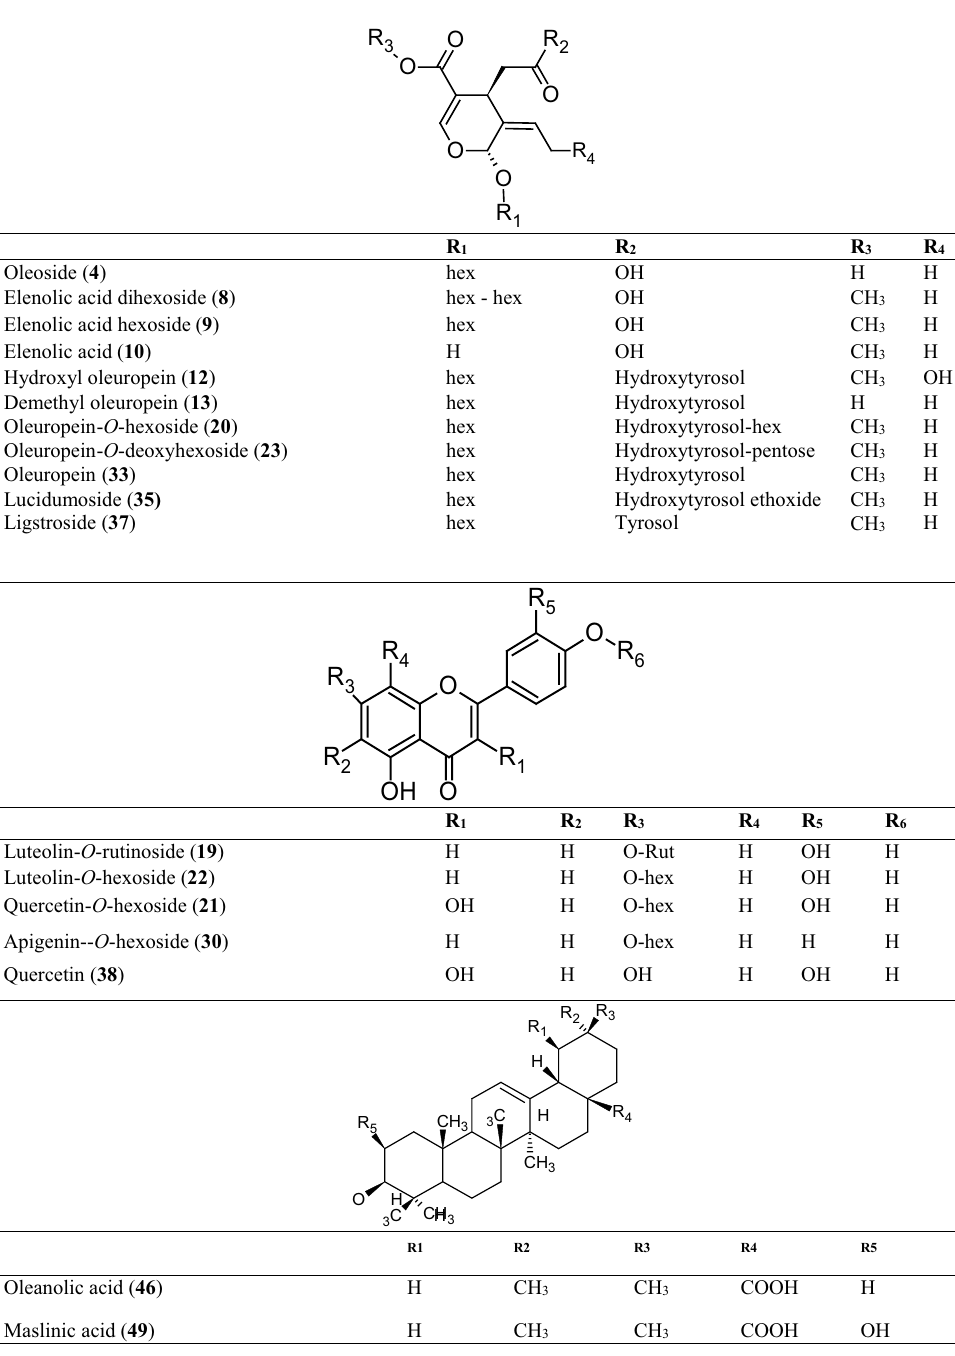
Figure 2. Representative classes of main metabolites tentatively identified in O. europaea leaf extracts: ( A ) secoiridoids, ( B ) flavonoids, ( C ) pentacyclic triterpenes with selected compounds discussed in the